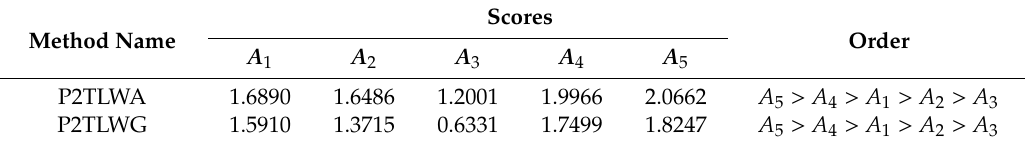
Table 22. Results of alternatives.